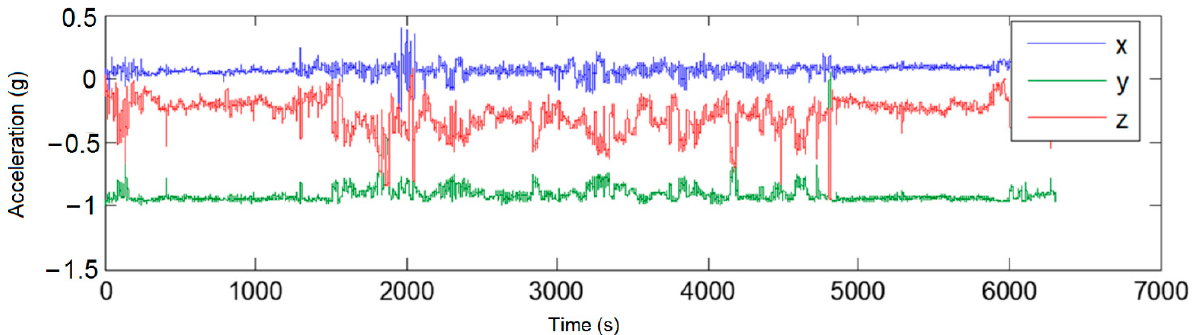
Figure 7. Diagram of KGA.